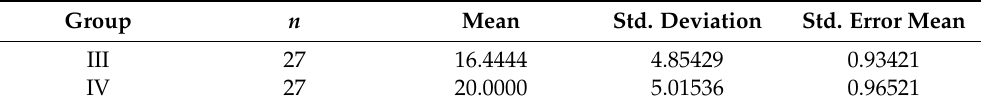
Figure 1. Mean values for the Perceived Stress Scale (x ± SD) pre-test/Trial-1 and post-test/Trial-2 training in DSN. Table 7. Mean results for Perceived Stress Scale for Groups III and IV post-test measurements.